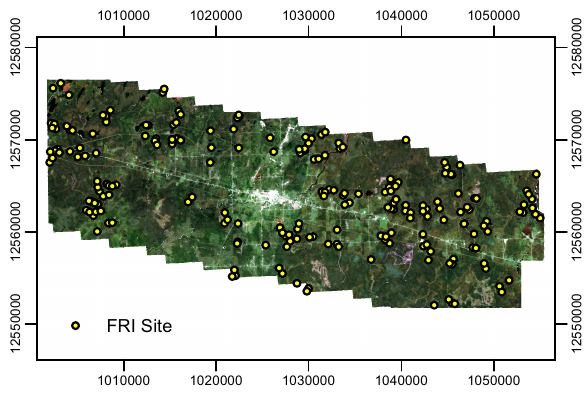
Figure 1 . True-color composite of the Hearst study area, with Ontario Forest Resources Inventory (FRI) sites denoted.